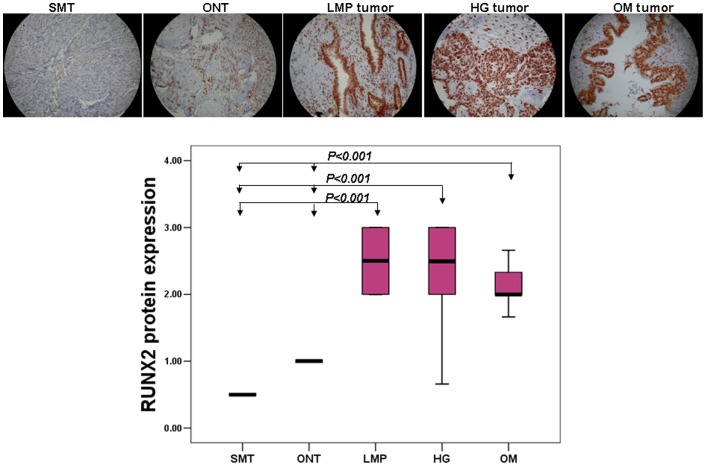
Analysis of RUNX2 expression in serous EOC tumors by IHC.A. Representative IHC images of RUNX2 protein expression in uterine smooth muscle tissues (SMT), normal ovarian tissues (ONT), LMP tumors, high-grade (HG) tumors and omental metastases (OM). B. Box-plot presentation of RUNX2 protein expression levels in SMT, ONT, LMP tumors, HG tumors and OM tumors. See Table S4 for statistical analyses.